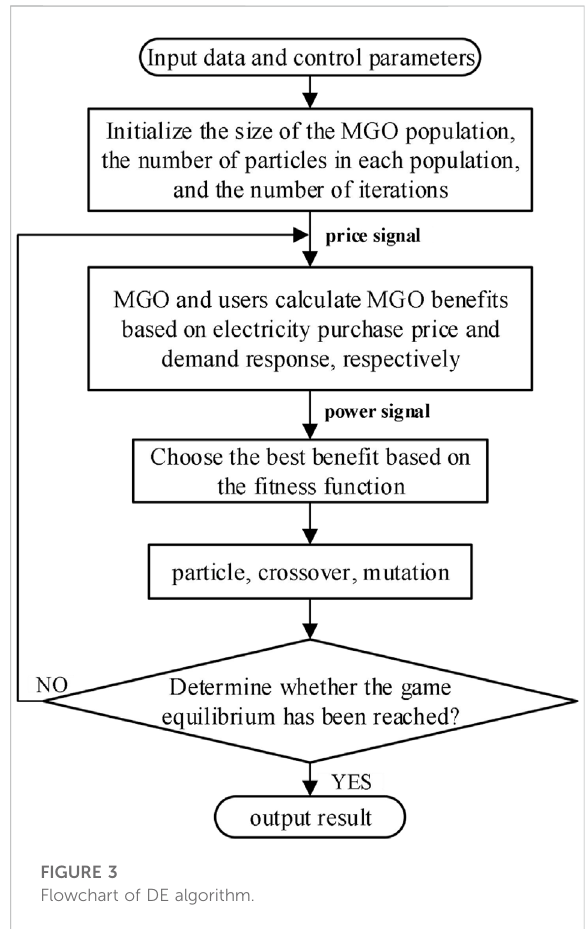
FIGURE 3 Flowchart of DE